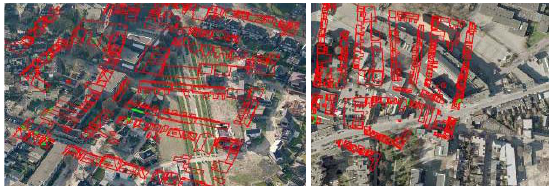
Figure 9. Verification results for simulated demolished buildings in oblique ©Blom and vertical images – red for